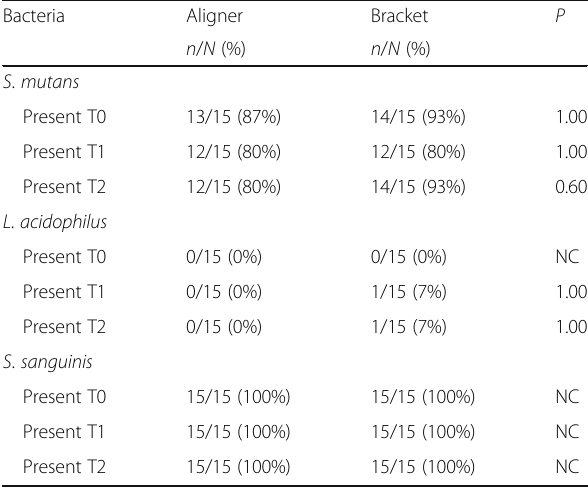
Table 4 Cross-tabulation of positive organisms ’ findings